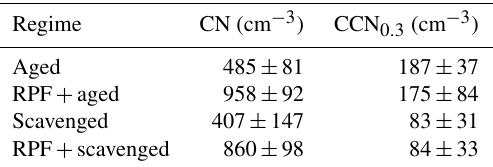
Table 1. Mean and standard deviation of CN and CCN 0 . 3 number concentration for the four identified regimes measured in the GV MBL